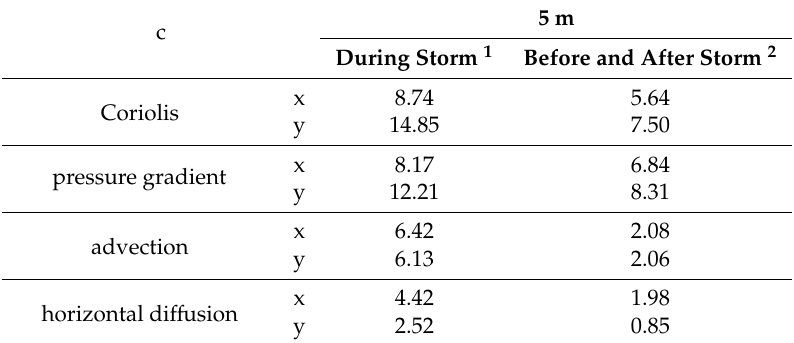
Table 1. Root mean square values of the terms in the momentum balance at MP. (units: 10 − 6 m s − 2 ).